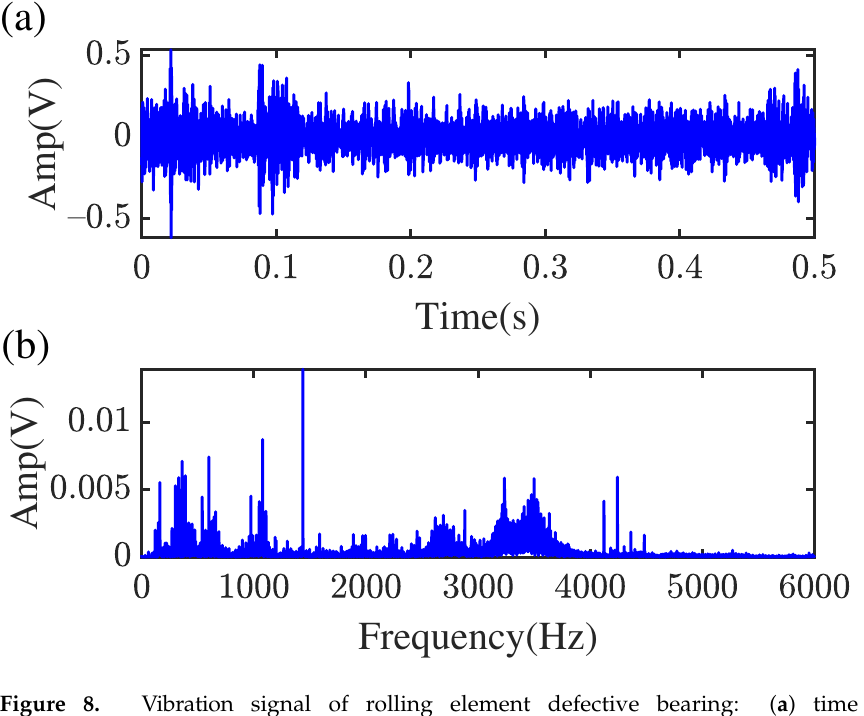
Figure 8. Vibration signal of rolling element defective bearing: ( a ) time waveform; ( b ) Fourier spectrum.